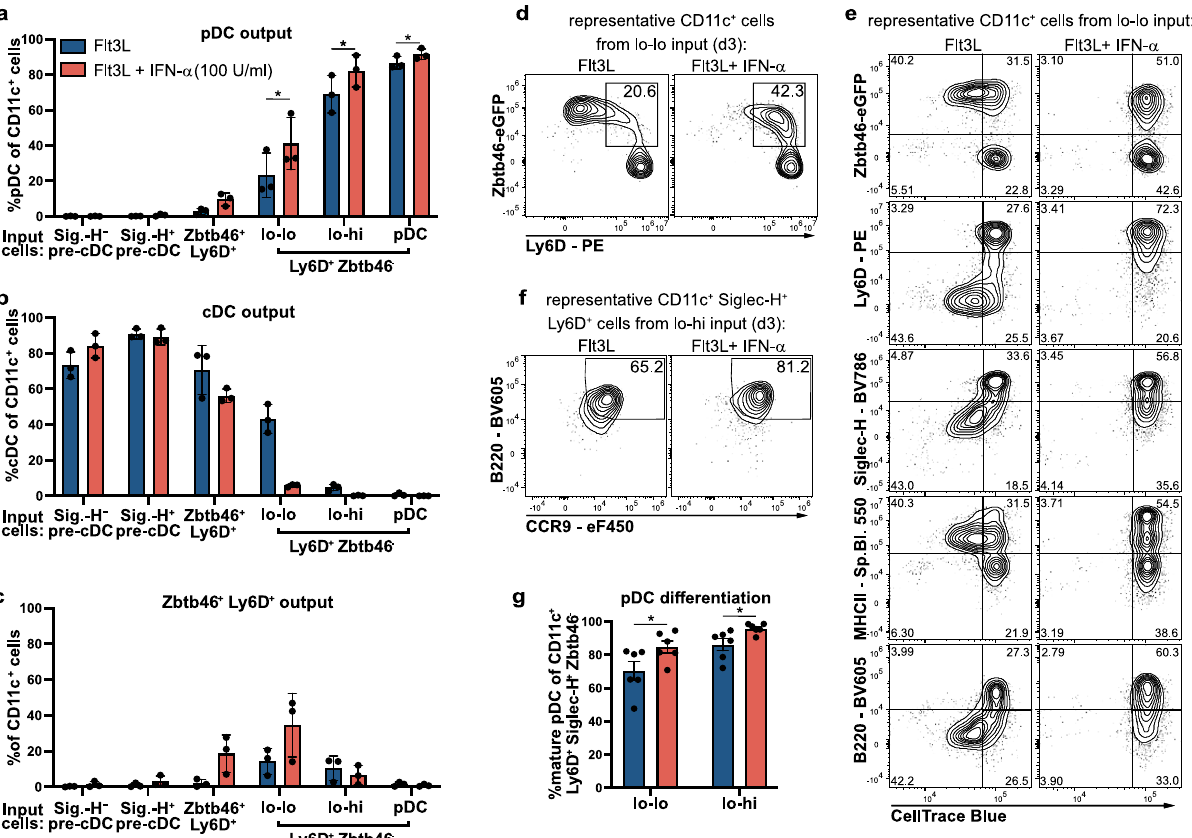
Fig. 6 Modulation of pDC versus cDC output from CD11c + Siglec-H + Ly6D + Zbtb46 – CCR9 lo B220 lo precursors by type I IFN in vitro. Siglec-H – pre-cDC, Siglec-H + pre-cDC, Siglec-H + Zbtb46 + Ly6D + cells and lo-lo, lo-hi and pDC (gated Siglec-H + Ly6D + Zbtb46 − ) were sorted from Lineage-depleted BM cells of heterozygous Zbtb46 gfp mice and cultured for 3 days with Flt3L only or Flt3L and 100 U/ml IFN- α on EL08-1D2 stromal cells. Percentages of pDCs a , cDCs ( b ), and Zbtb46 + Ly6D + cells ( c ) within CD11c + progeny after 3 days are shown for each input population as mean ± SEM ( n = 3). d Zbtb46 vs. Ly6D expression in CD11c + cells derived from lo-lo precursors with Flt3L alone (left) and Flt3L/IFN- α (right); representative results of three experiments. e Expression of Zbtb46 and several surface markers vs. CTB signal. Representative example of CD11c + cells generated from lo-lo precursors after 3 days of culture with Flt3L alone (left) and Flt3L/IFN- α (right, n = 3). f Representative example of B220 vs. CCR9 expression and pDC gating of CD11c + Siglec-H + Ly6D + cells derived from lo-hi precursors after 3d of culture ( n = 5). g Percentage of differentiated pDCs within CD11c + Siglec-H + Ly6D + Zbtb46 – cells derived from lo-lo and lo-hi precursors after 3d of culture with and without IFN- α addition (mean ± SEM, n = 5). Conditions with and without IFN- α were compared for each input population using paired, two-sided t-tests with Holm – Š ídák correction for multiple testing. Adjusted p -values: